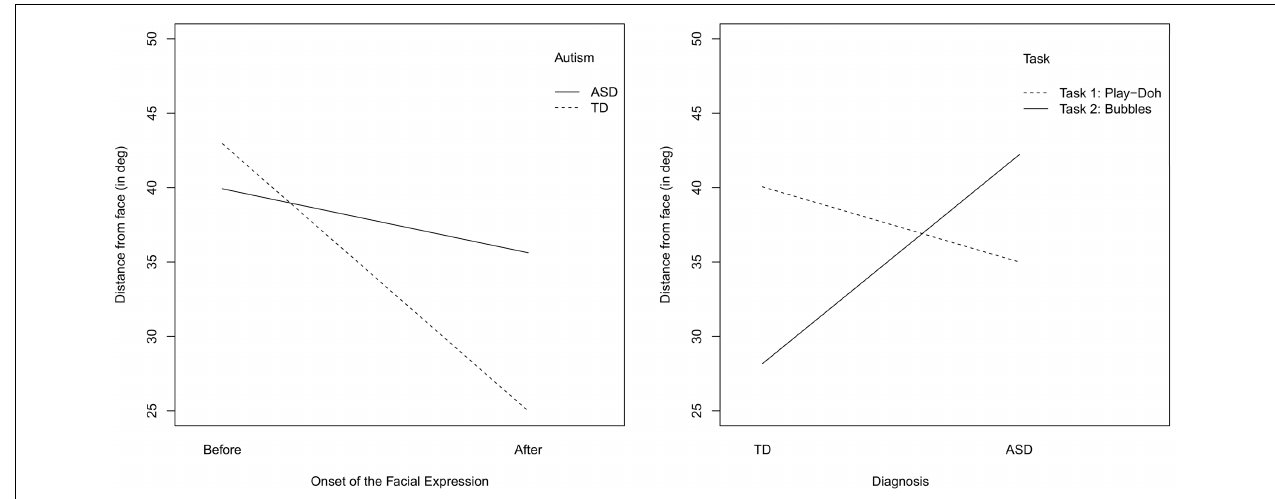
FIGURE 5 | Facial expression condition: interaction plots of the mean value of the gaze-to-face distance, computed over temporal intervals before and after the onset of the facial expression. Both the intervals before and after the onset correspond to temporal window of 1200ms (i.e., 30 frames).